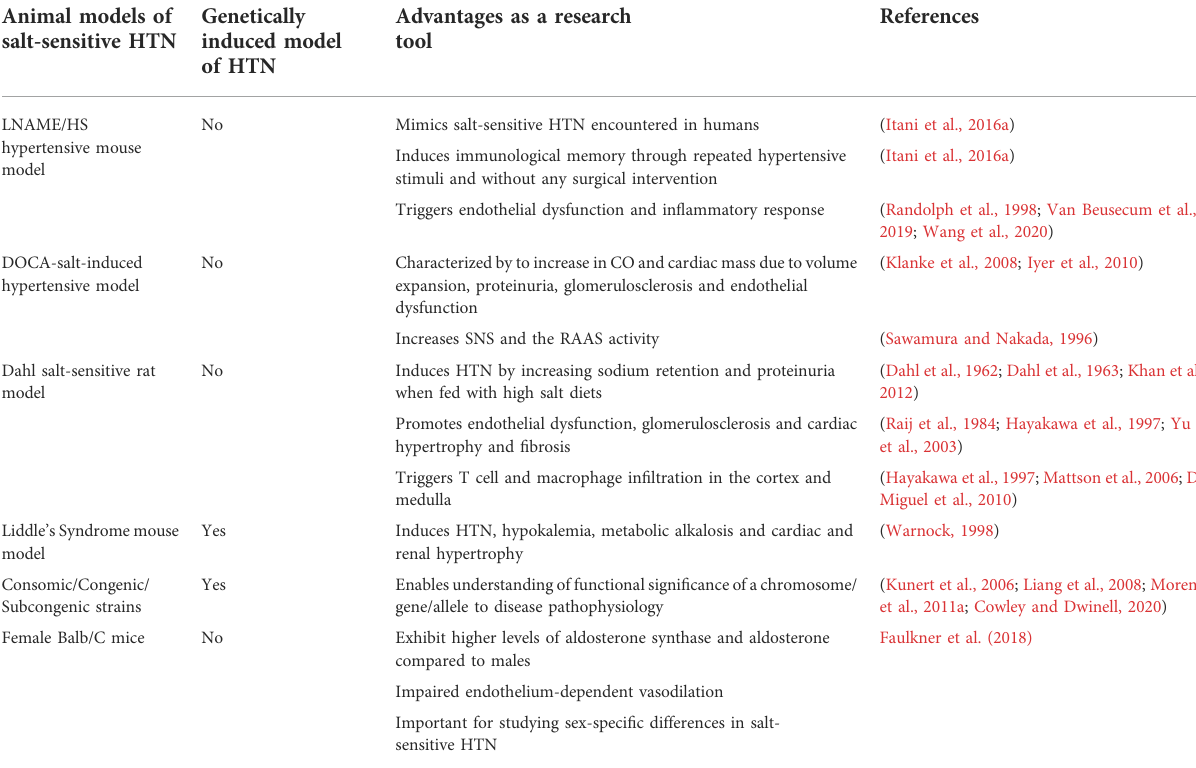
TABLE. 1 Animal models used to study salt-sensitive HTN and hypertensive end-organ damage. Animal models of Genetically salt-sensitive HTN induced